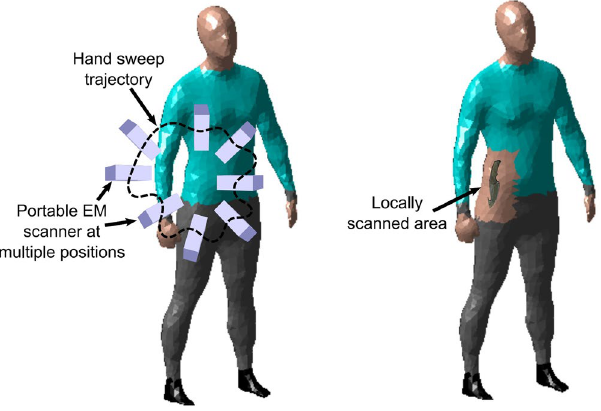
Figure 1. Application example for locally scanning in search of concealed